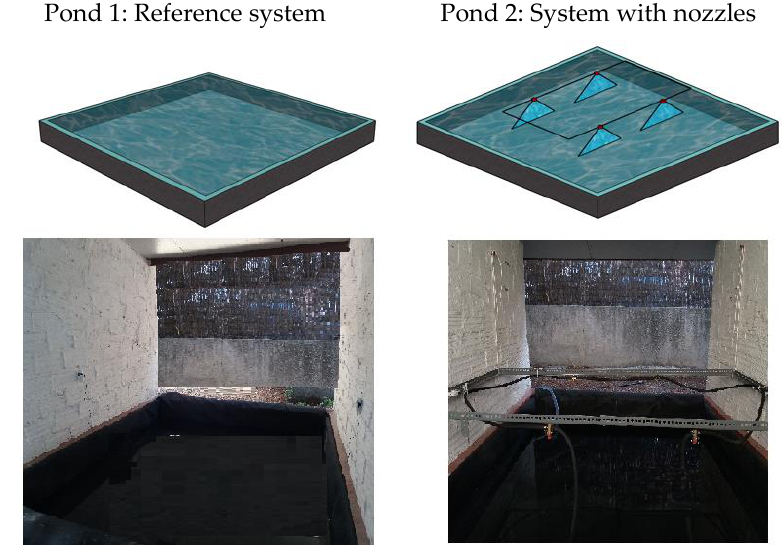
Figure 1. Experimental and reference ponds.